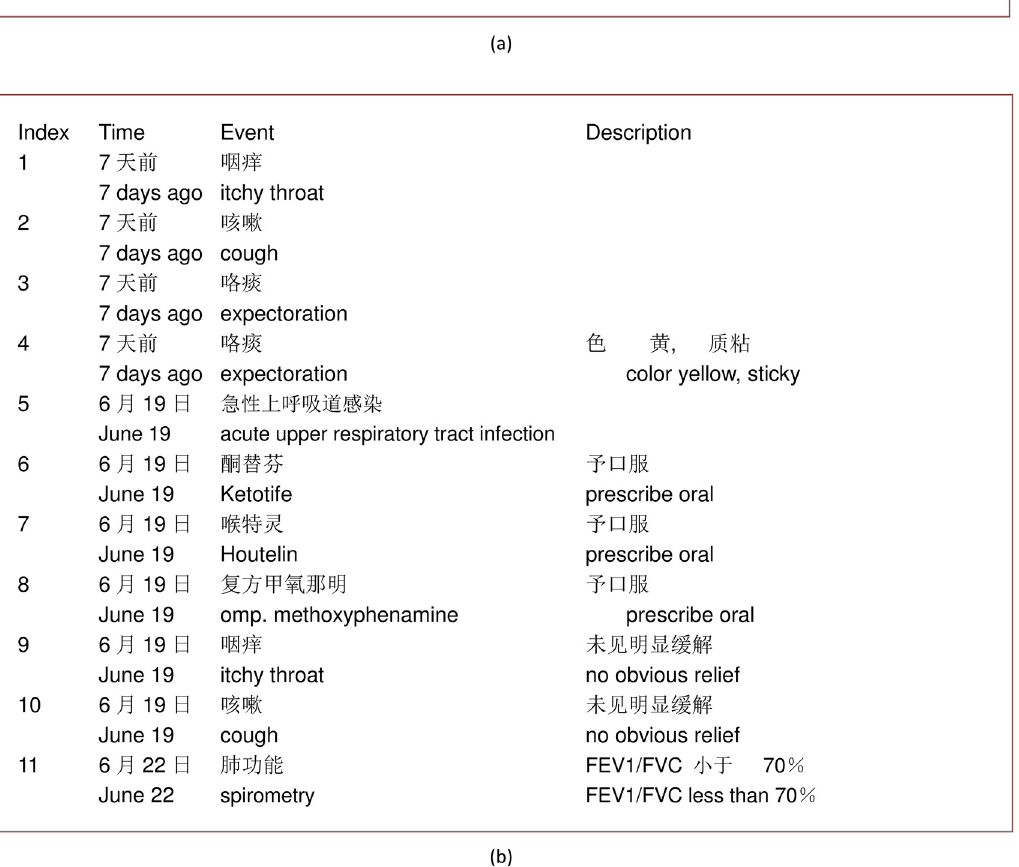
Fig 1. An example of Chinese EMR and structured records extracted from this EMR. (a)a paragraph from an HPI in Chinese with inline literal translation in English. (b)time-event-description triples in Chinese with inline literal translation in English.